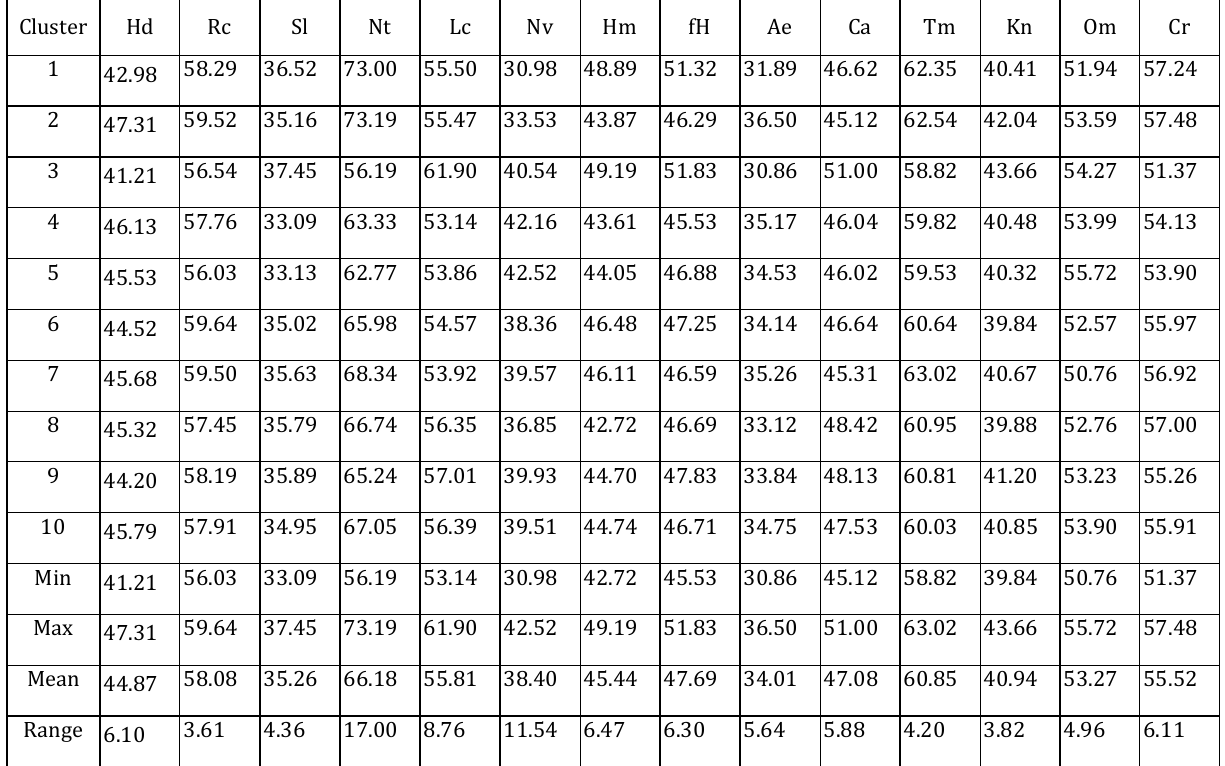
Table 1. Average values of phytoindicational indicators calculated for syntaxa of the afforestation belts Cluster Hd